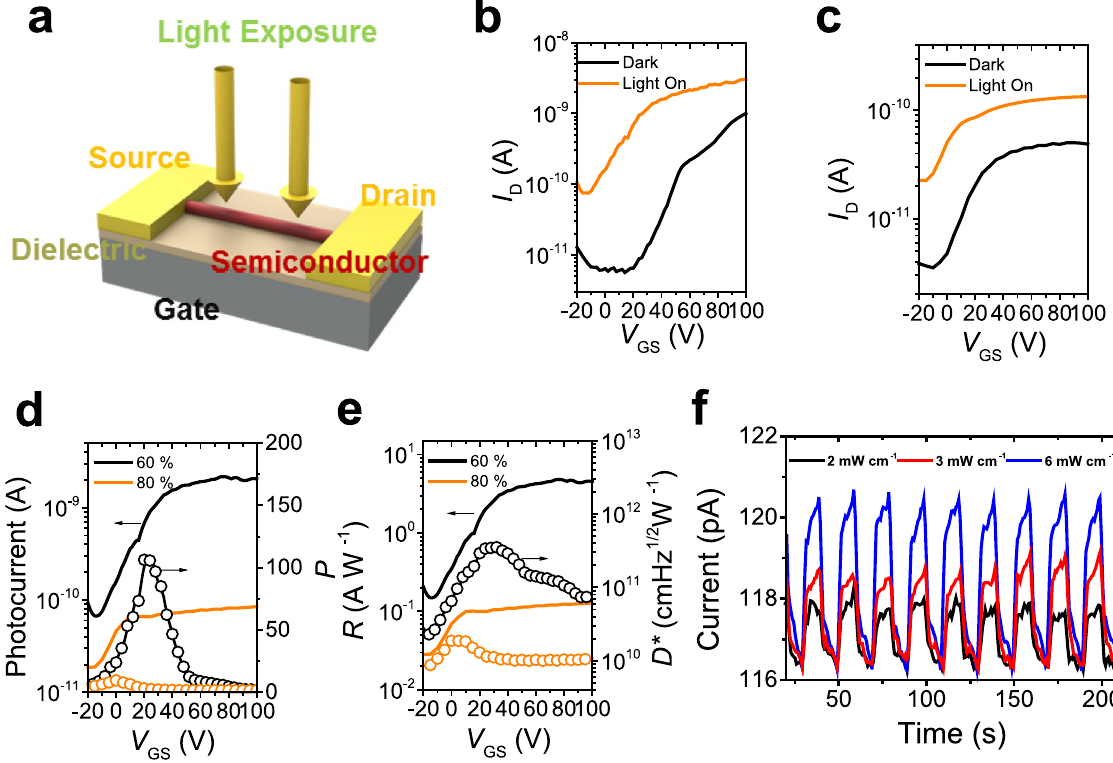
Figure 5. ( a ) Schematic diagram of organic field-effect transistor based on nanomaterials. Transfer curves of ( S )-CPDI-Ph OPTs based on nanomaterials in THF/water mixed solutions (1.0 × 10 − 5 M) with f w of ( b ) 60% (average W / L = 0.017) and ( c ) 80% (average W / L = 0.006). ( d ) Photocurrent and photocurrent/dark current ratio of the NM-OPTs. ( e ) Responsivity and detectivity of the NM-OPTs. ( f ) Photo-switching results of nanomaterials in THF/water mixed solution (1.0 × 10 − 5 M) with f w = 60% under various intensity of polychromatic light illumination.